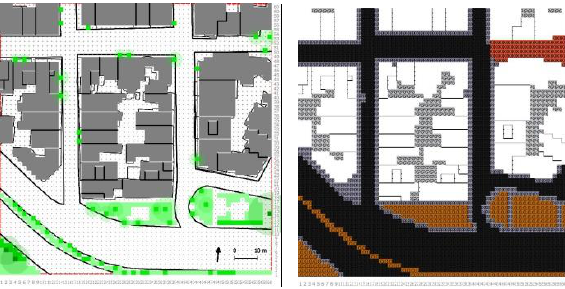
Figure 3: Material types of the study area. Land cover materials (right), materials of the structured environment and vegetation (left) – (2D View).